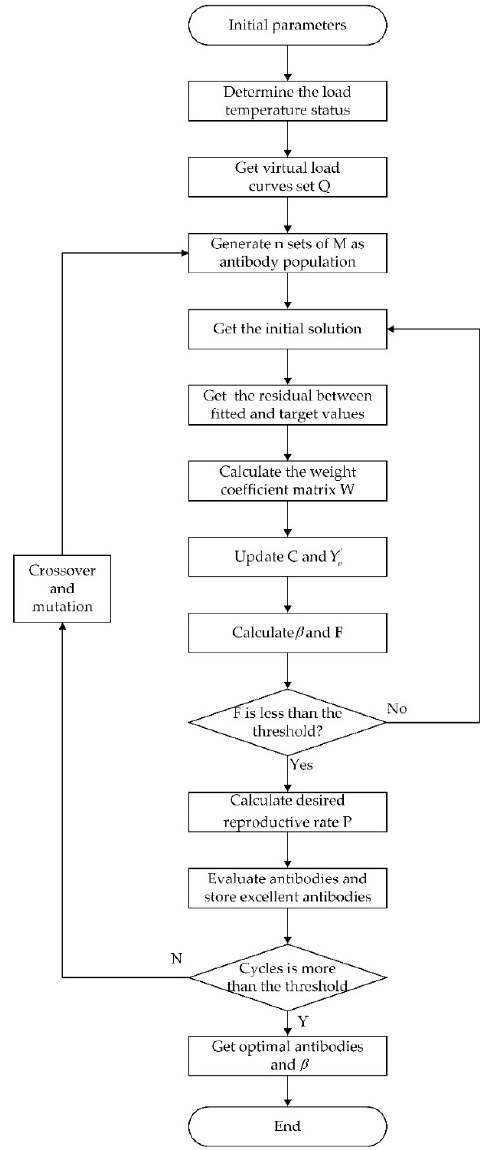
Figure 7. Algorithm flow chart.